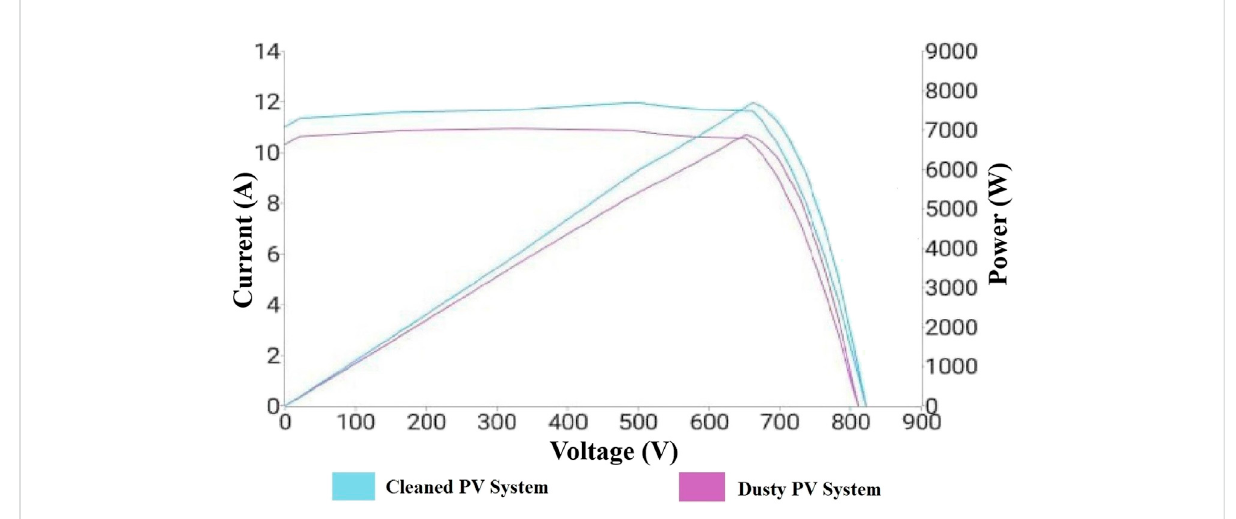
FIGURE 12 I – V curve of cleaned and dusty PV systems to compare system performance in June.